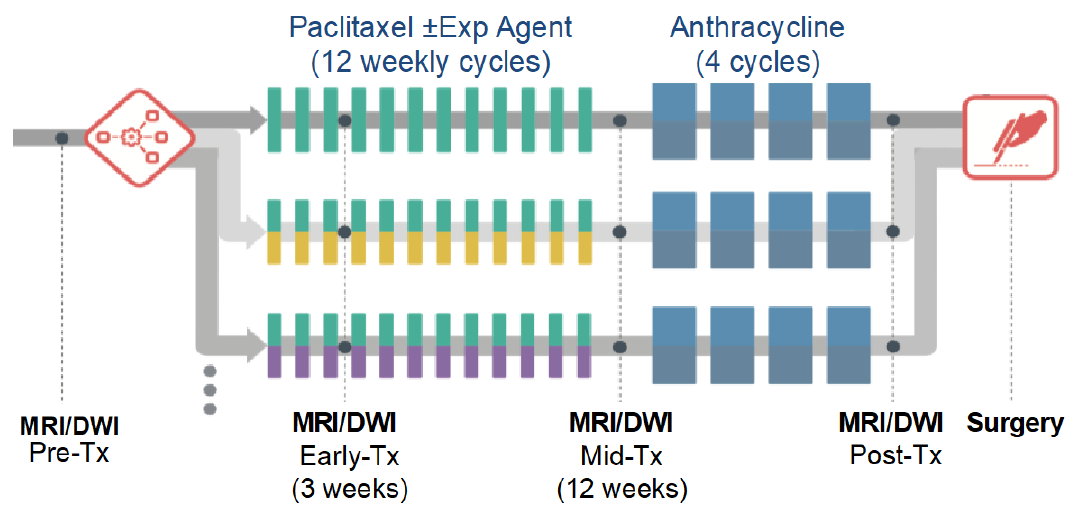
Figure 2. ECOG-ACRIN A6698 and parent I-SPY 2 Trial study schema. Exp, experimental; Tx, treat- ment. Reprinted with permission from Partridge et al. Radiology 2018; 289(3):